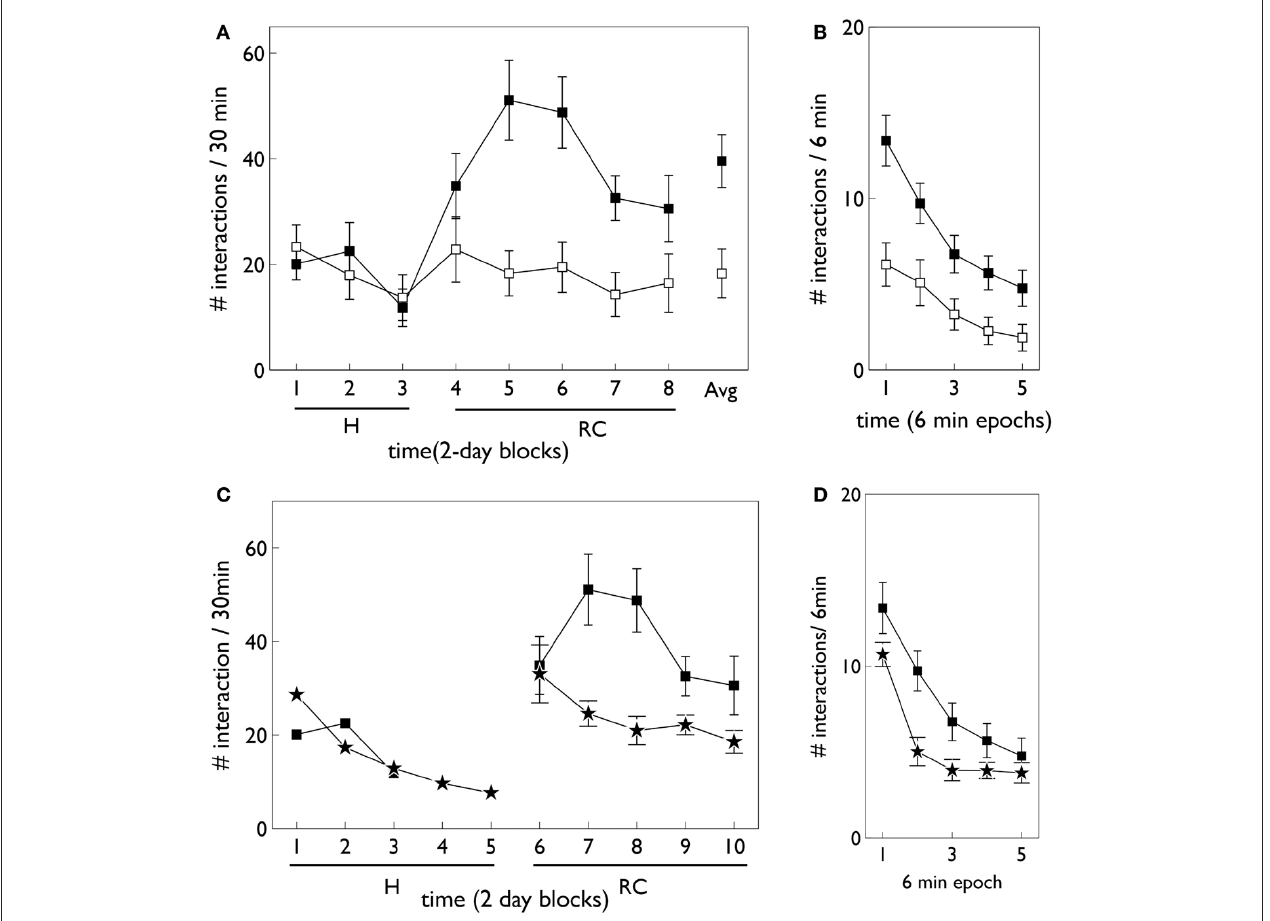
FIGURE 3 | Behavioral data adapted from the in vivo studies of Gancarz et al. (2011) (study 1) and Lloyd et al. (2012) (study 2). (A,B) For variable interval (VI) training from study 1. (A) Shows the number of inactive and active responses in each 2-day period (averaged over the two 30min sessions therein) with white and black symbols, respectively. The habituation and response contingent phases (see text) are designated “H” and “RC,” respectively, and the average response during the response contingent phase is shown on the extreme right as “Avg.” (B) Shows the within-session behavior during the response contingent phase. Results are averaged over all